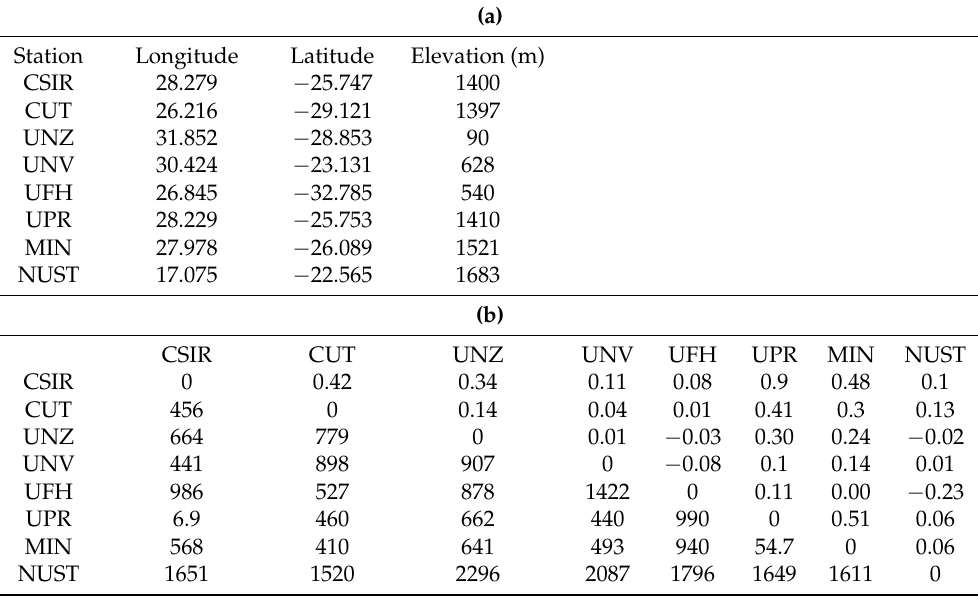
Table 3. ( a ) Longitude, latitude and elevation. ( b ) Distance (km) matrix for the eight radiometric